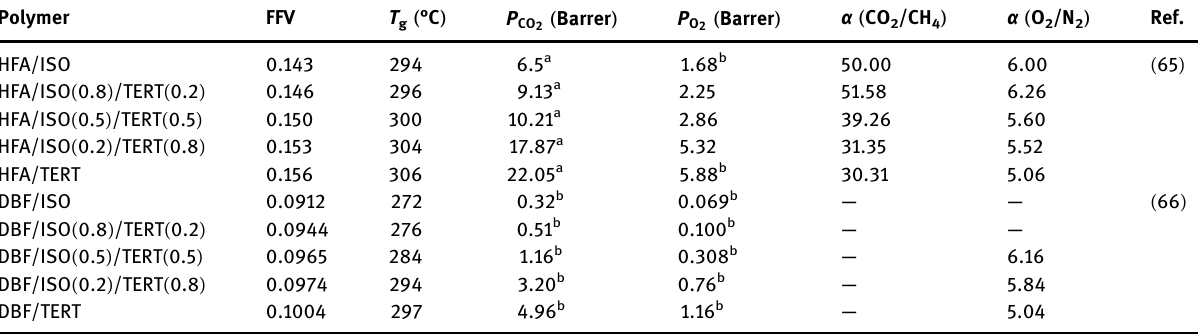
DBF/ISO ( 0.5 ) /TERT ( 0.5 ) DBF/ISO ( 0.2 ) /TERT ( 0.8 )